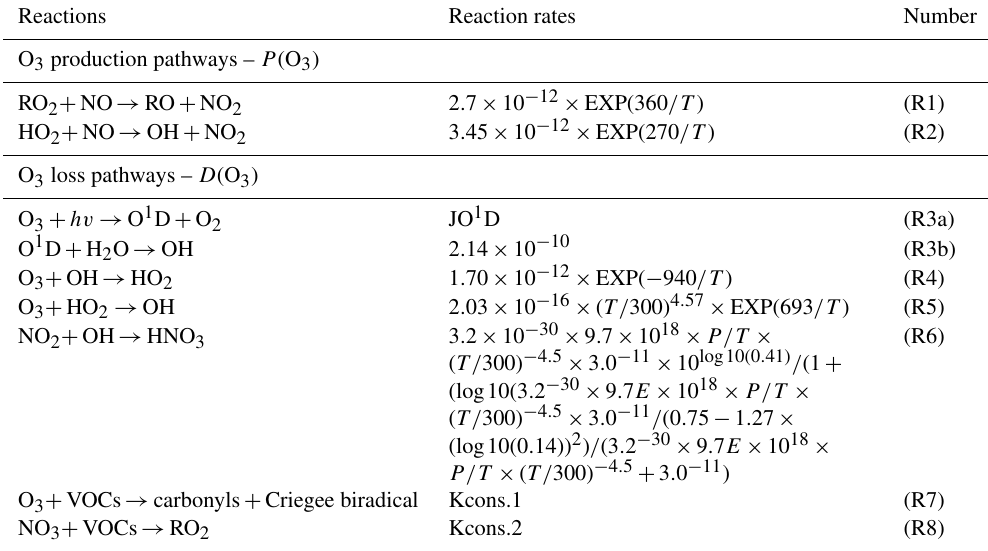
Table 1. Simulated production and destruction reactions and relevant reaction rates of O 3 in our study.